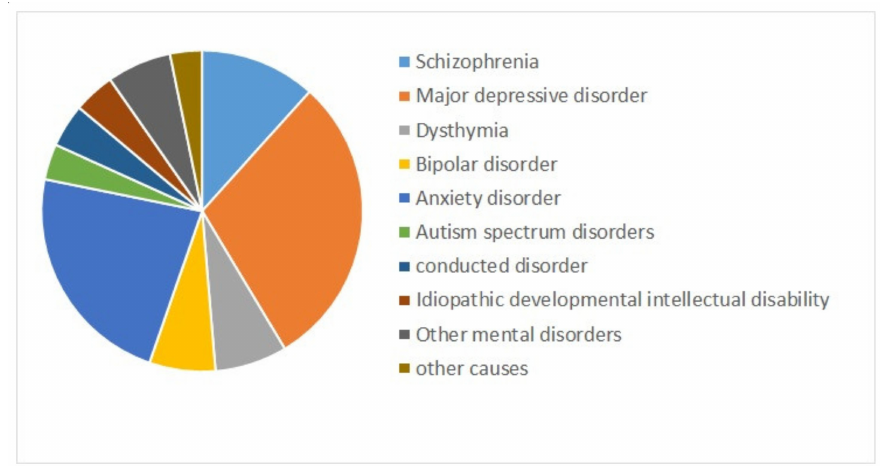
Figure 1. The contribution of mental disorders to Disability Adjusted Life Years (DALYs) worldwide, for both sexes combined, 2019 [6].